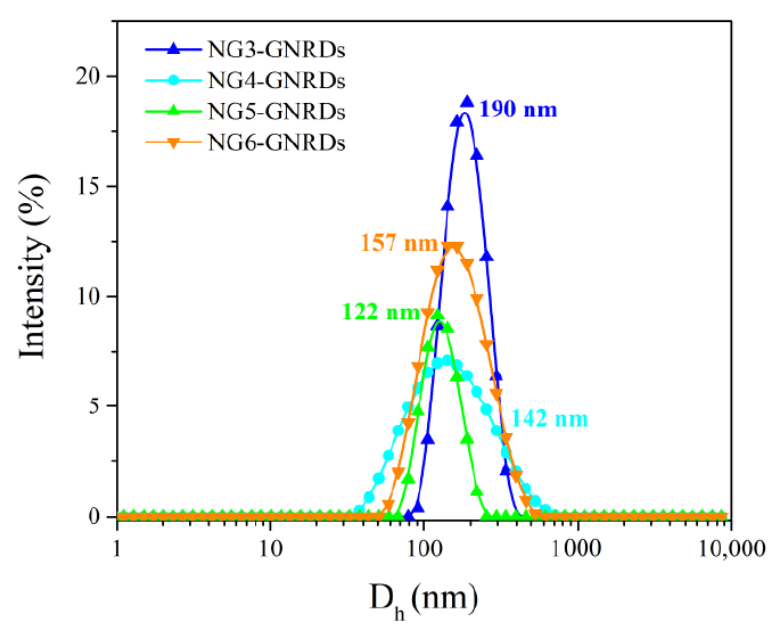
Figure 7. Size distribution by intensity of GNRDs encapsulated into PNVCL-based nanogels.